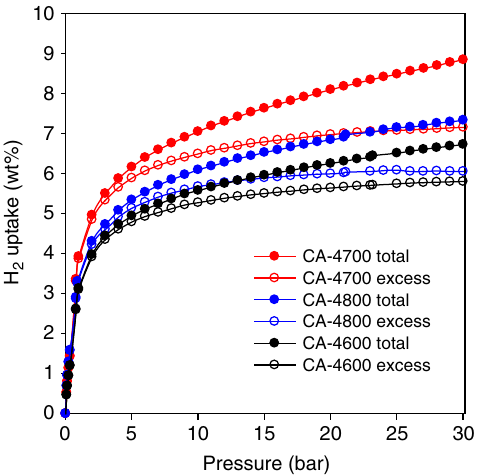
Fig. 6 Gravimetric hydrogen storage capacity of activated carbons. Excess and total hydrogen uptake at − 196 °C of activated carbons derived from cellulose